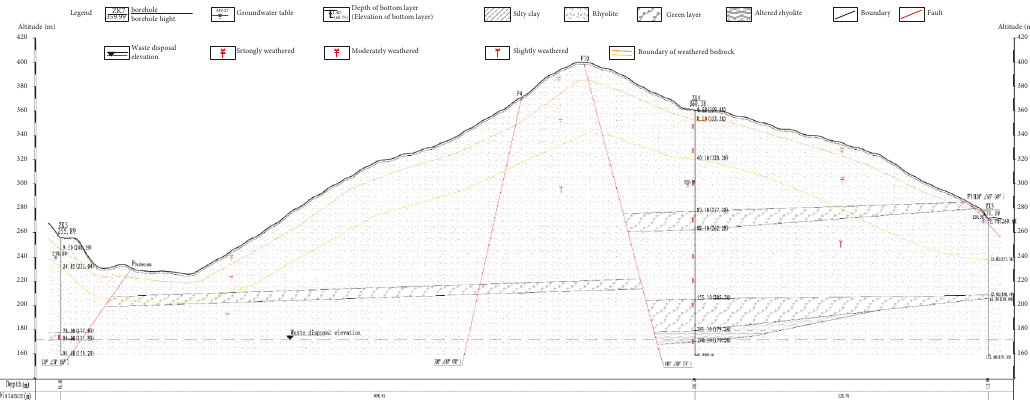
Figure 1: The exploration profiles of the site.